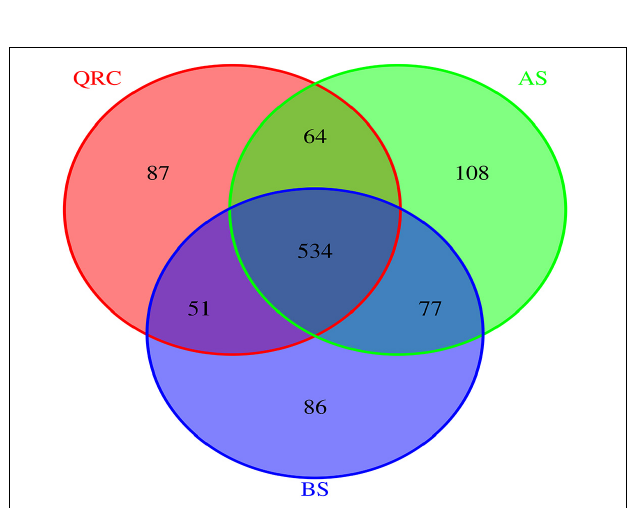
FIGURE 2 | Venn diagram reveals the overlap of fungal nirK OTUs among three soil types. AS, alluvial soils; BS, black soils; QRC, quaternary red clay soils.